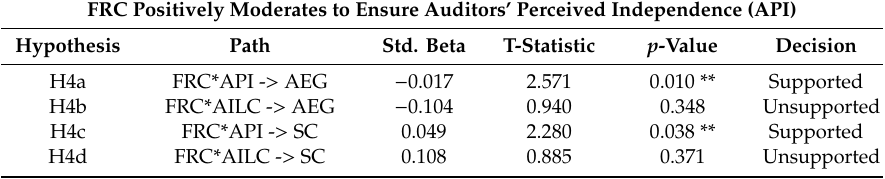
Table 5. Hypothesis testing of moderating